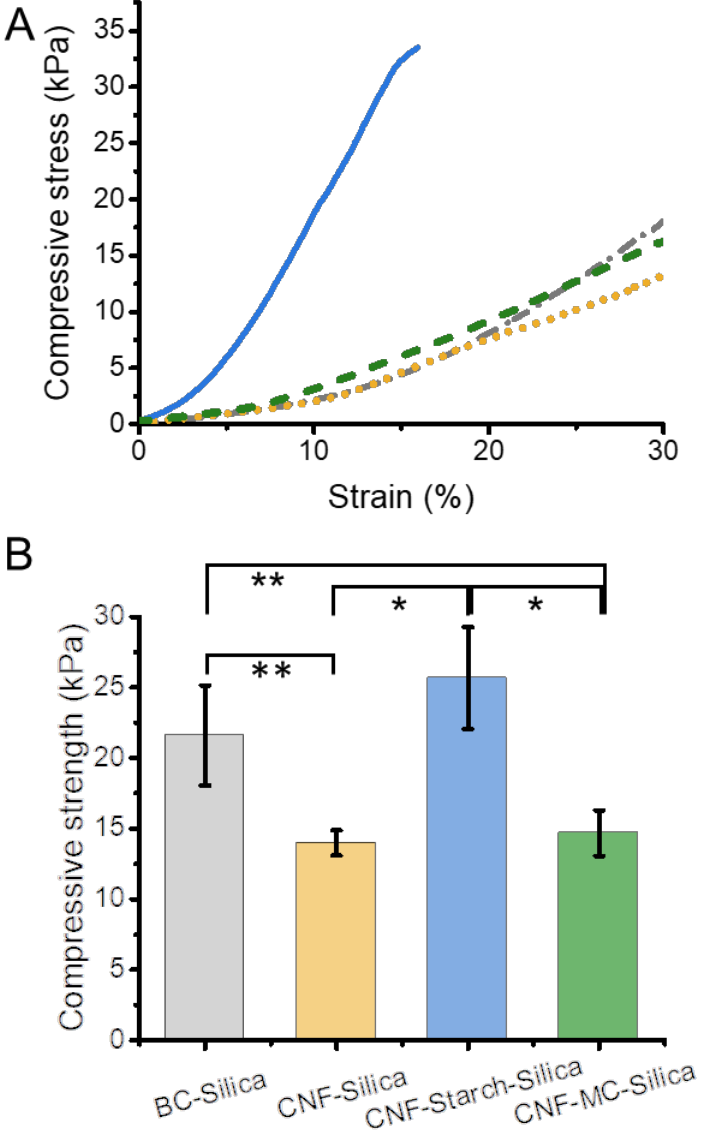
Figure 2. Mechanical properties of the prepared CNF–silica hydrogels and influence of the addition of the soluble polysaccharides—starch or methylcellulose (MC)—on the compression behavior. ( A ) Compression tests of the CNF–Silica hydrogels up to 30% strain (CNF–silica: dotted yellow line, CNF–MC–Silica: green dashed line, and CNF–Starch–Silica: blue solid line) in comparison to bacterial cellulose (BC) silica gel (dash-dotted gray line). ( B ) Comparison of the average compressive strengths and their standard deviation of the samples. Highlighted differences are statistically significant (* p < 0.04, ** p < 0.04, n = 3).